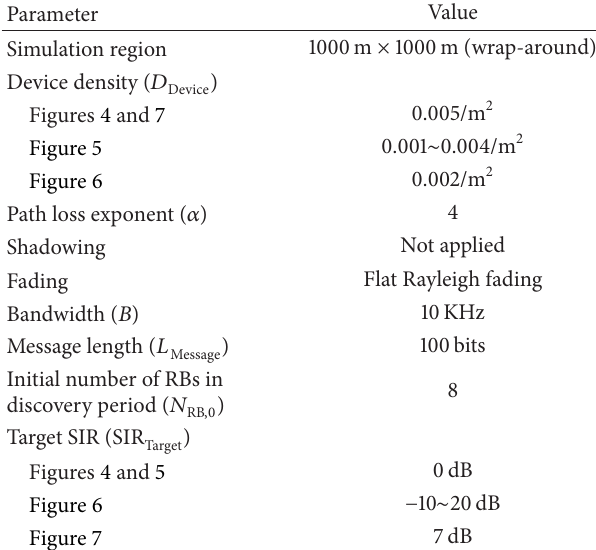
Table 1: Simulation